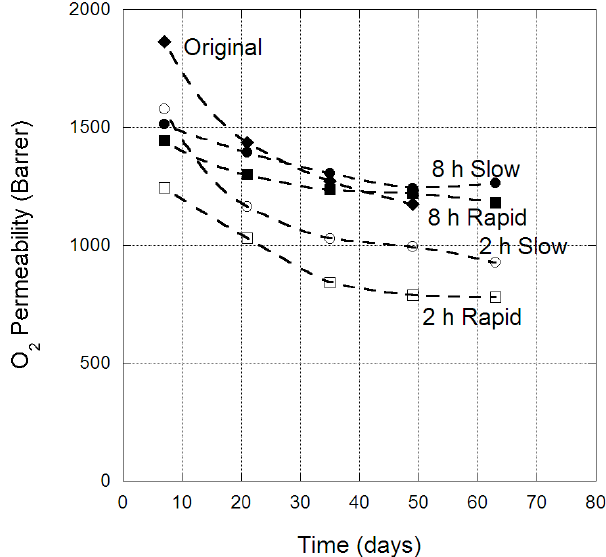
Figure 7. O 2 permeability (barrer) in PIM-1 membrane over time, for the original and scCO 2 -treated states, at 35 °C.